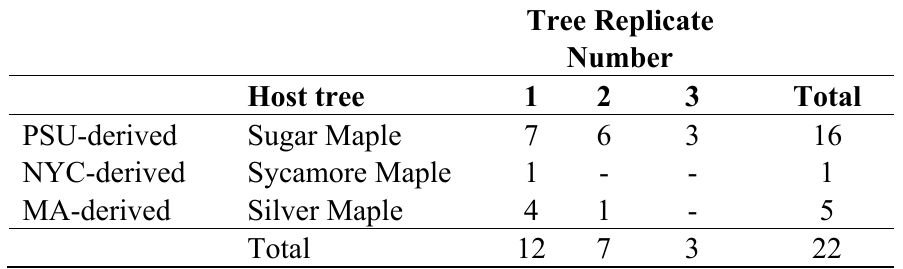
Table 1. Number of monoconidial gut-derived fungal cultures from each host tree. Tree